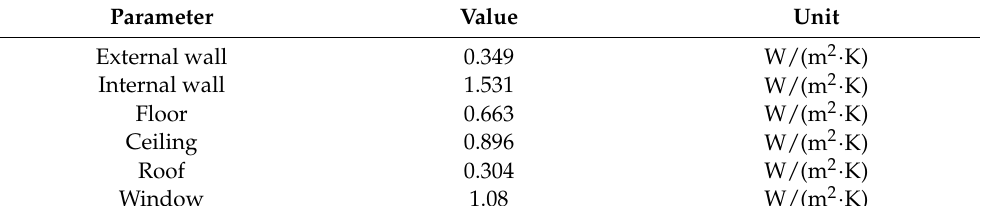
Table 3. Heat transfer coefficient of wall.